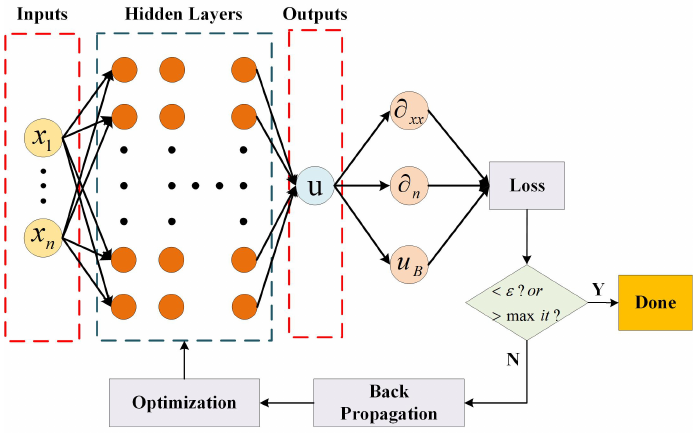
Figure 2. A schematic plot of